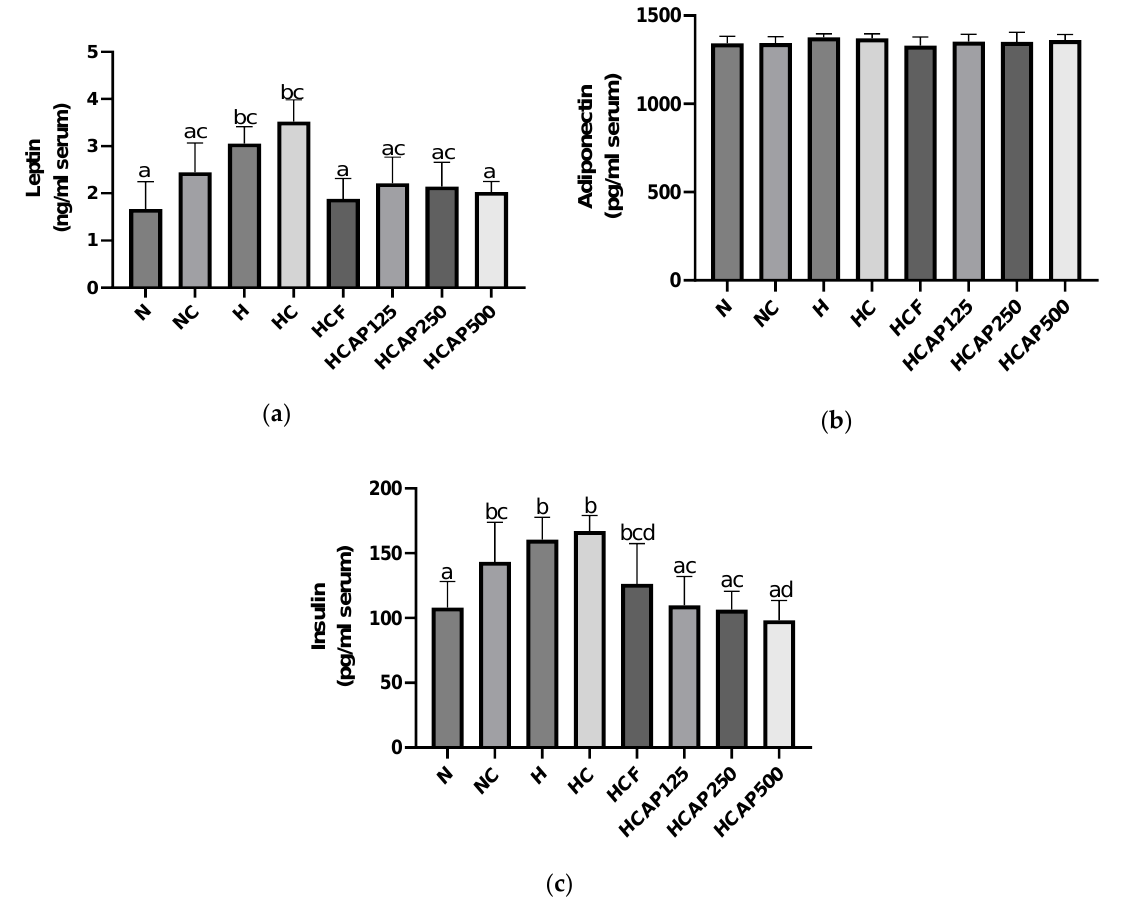
Figure 7. ( a ) Impact of A. paniculata on the serum leptin of treated rats. ( b ) Impact of A. paniculata on the serum adiponectin of treated rats. ( c ) Impact of A. paniculata on the serum insulin of treated rats. The data are given as mean ± SE. Mean values with distinct alphabetical letters were significantly different at p < 0.05 (ANOVA, Tukey’s post hoc). N, normal diet; NC, normal diet + DMH; H, HFD; HC, HFD + DMH; HCF, HFD + DMH + 5-FU; HCAP125, HFD + DMH + 125 mg/kg A. paniculata ethanol extract; HCAP250, HFD + DMH + 250 mg/kg A. paniculata ethanol extract; HCAP500, HFD + DMH + 500 mg/kg A. paniculata ethanol extract.